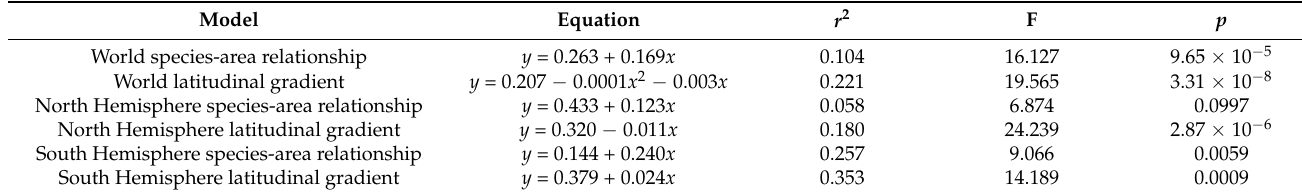
Table 1. Earwig species–area relationships and latitudinal diversity gradients for world mainland and island countries. Species–area relationships were modelled using the linearized version of the power function: log( S ) = log( c ) + z log( A ), where S is the recorded species richness at country level, A is country area, and z and c are estimated parameters. Latitudinal gradients were modelled with regressing residuals from the species–area relationships (SAR residuals) against country latitude with a second-order polynomial regression for the whole dataset and with linear regressions for the two hemispheres separately. r 2 = coefficient of determination; F = Fisher’s F; p =